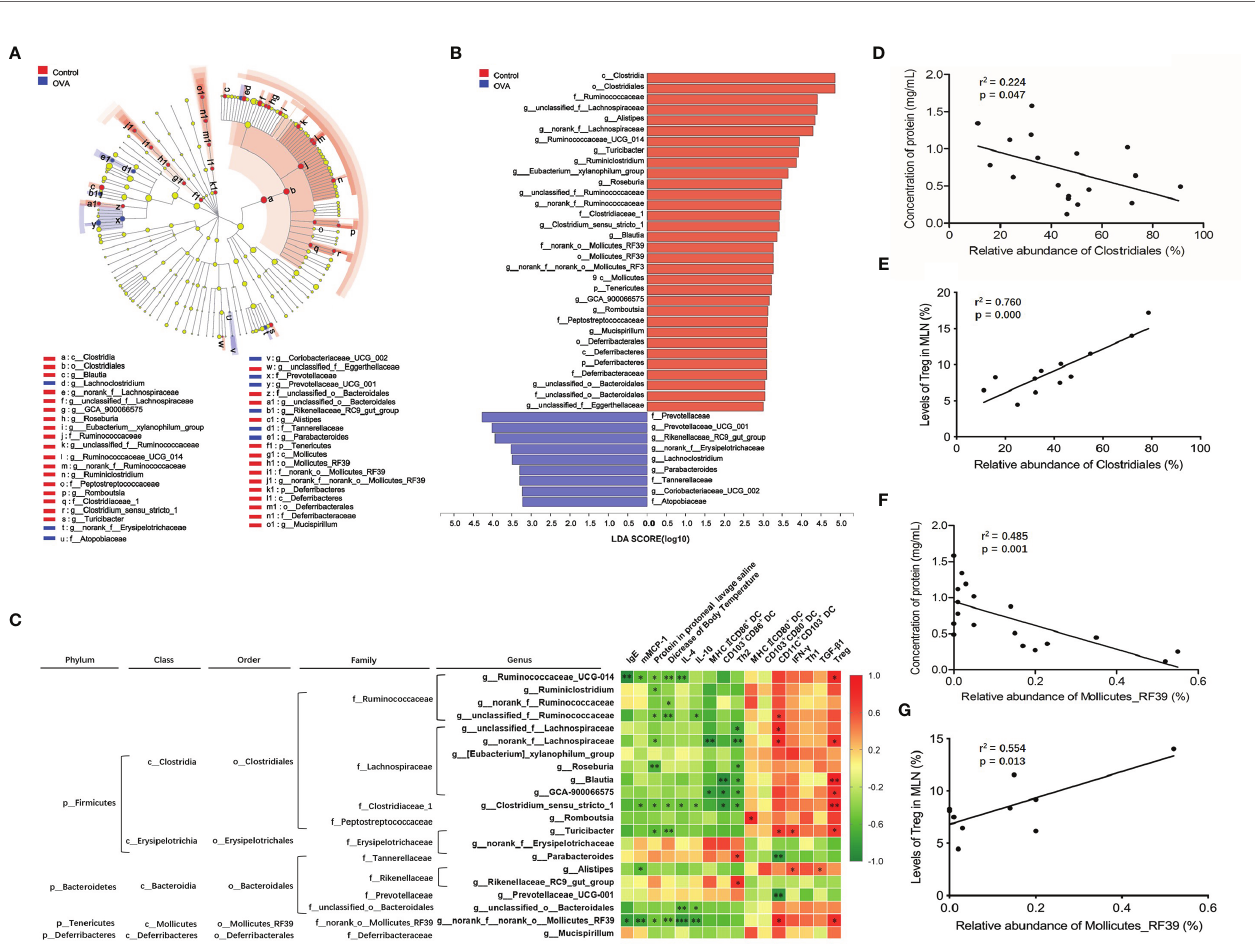
FIGURE 8 | Identi fi cation of intestinal microbiota accounting for allergy and their correlation with allergic parameters in MLN. (A) Cladogram showing the phylogenetic distribution of the bacterial lineages associated with allergy from the two groups. Different-colored regions represent different constitutes. Circles indicate phylogenetic levels from phylum to genus. The diameter of each circle is proportional to the abundance of the group. (B) Indicator bacteria with LDA scores of 3 or greater in bacterial communities associated with allergy from two groups. (C) Heat map showing the Spearman correlation coef fi cient between identi fi ed signi fi cantly different species from phylum to genus level and the allergic indexes in MLN. (D, E) Spearman correlation of the order Clostridiales in intestinal microbiota with protein concentration in peritoneal lavage saline and Treg in MLN. (F, G) Spearman correlation of the order Mollicutes_RF39 in intestinal microbiota with protein concentration in peritoneal lavage saline and Treg in MLN. *, ** and *** refer to signi fi cant Spearman correlation ( p ≤ 0.05, p ≤ 0.01, p ≤